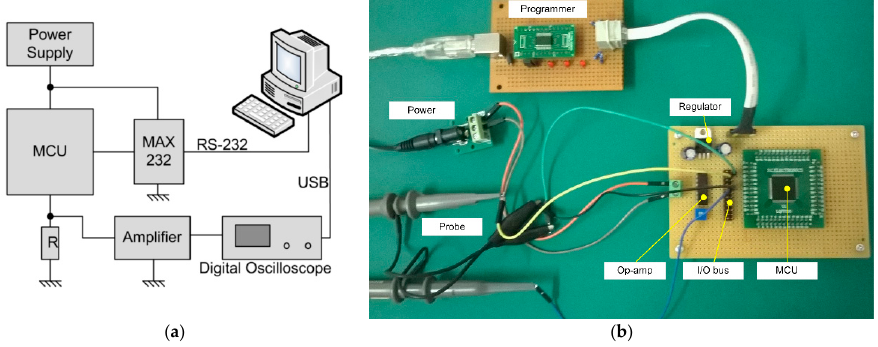
Figure 2. Experimental setup ( a ) hardware diagram ( b ) photograph of operating